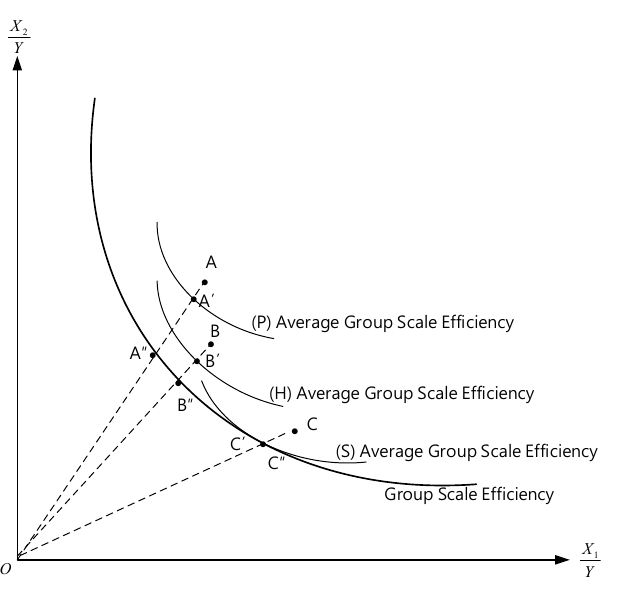
ffi ciency and average scale e ffi ciency of each Figure 1. Group scale efficiency and average scale efficiency of each group. Figure 1. Group scale e